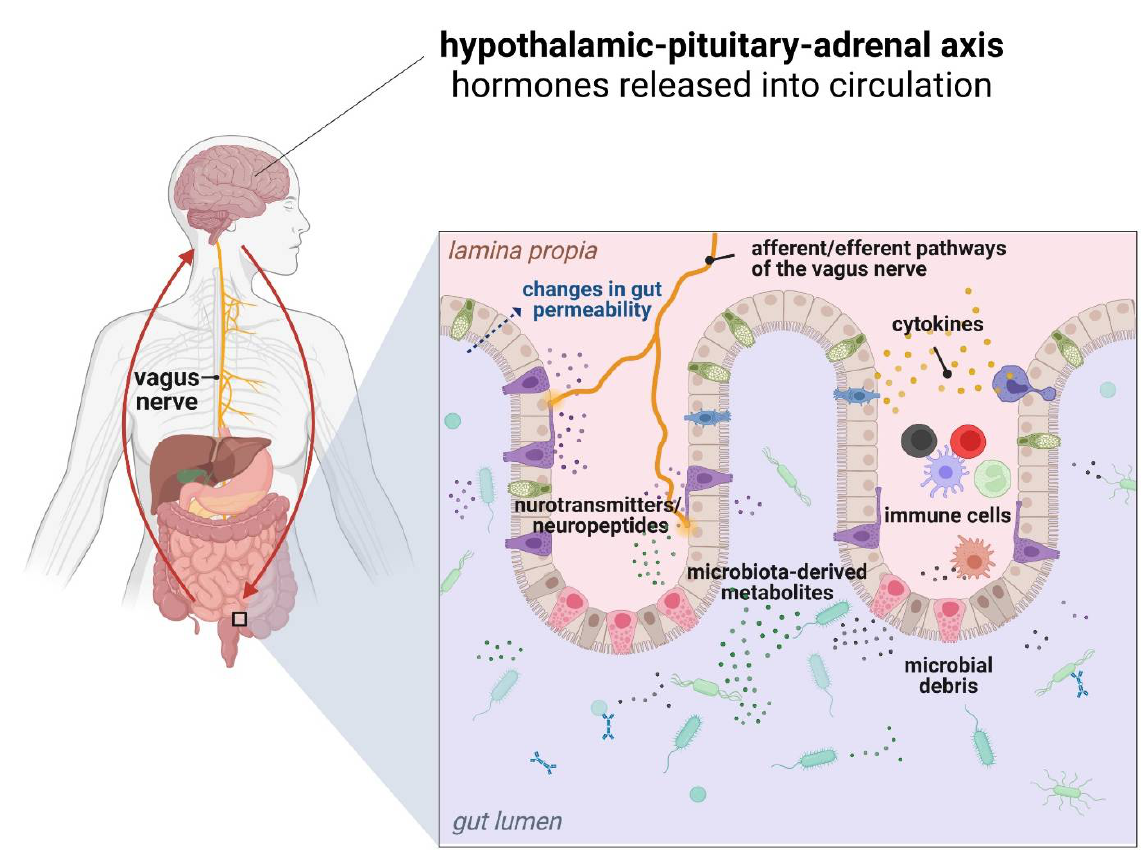
Figure 3. Various bidirectional communication pathways within the gut microbiota-immune system-brain axis [own drawing].